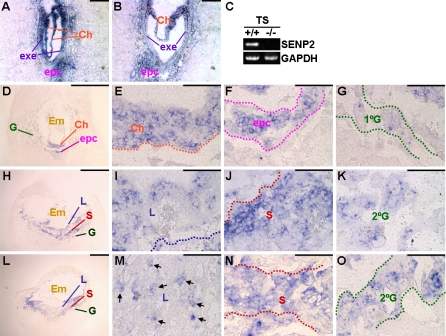
SENP2 Is Expressed in Trophoblast Lineage Development(A and B) In situ hybridization reveals that SENP2 is expressed in the trophoblast stem cell niches, including extraembryonic ectoderm (exe) , chorion (Ch) and ectoplacental cone (epc) at E7.0 (A) and E7.5 (B).(C) RT-PCR analysis detected the SENP2 transcript in wild-type (+/+), but not knockout (–/–) TS cells.(D–O) Sections of the E8.5 (D–G), E9.5 (H–K) and E10.5 (L–O) placentas were analyzed by in situ hybridization for the expression of SENP2. Expression was detected in major extraembryonic tissues. Low magnification images display the overall expression pattern in developing placentas (D,H,L). High magnification images show expression in specific cell types and layers (E–G,I–K,M–O). The chorion, ectoplacental cone, labyrinth (L), spongiotrophoblast (S), and TGC (G; 1°, primary; 2°, secondary) layers are defined by orange, pink, blue, red, and green broken lines, respectively. Arrows indicate specific expression in mononuclear trophoblasts (cytotrophoblasts) of the labyrinth layer (M).Em, embryo. Scale bars, 1 mm (D,H,L); 100 μm (A,B,E–G,I–K,M–O).